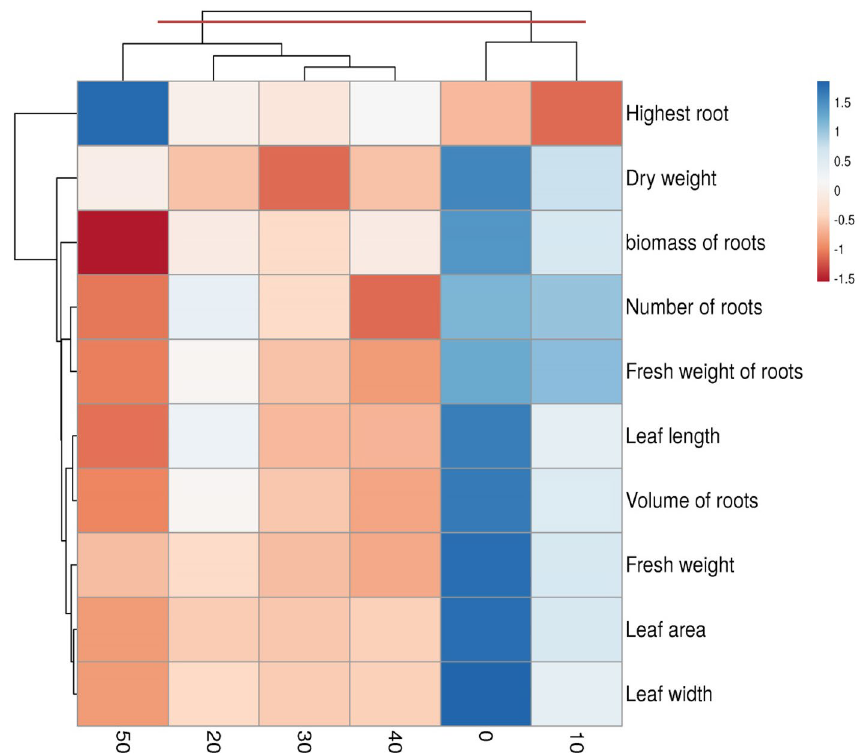
Figure 6. Cluster analysis of the studied traits in different gamma treatments.